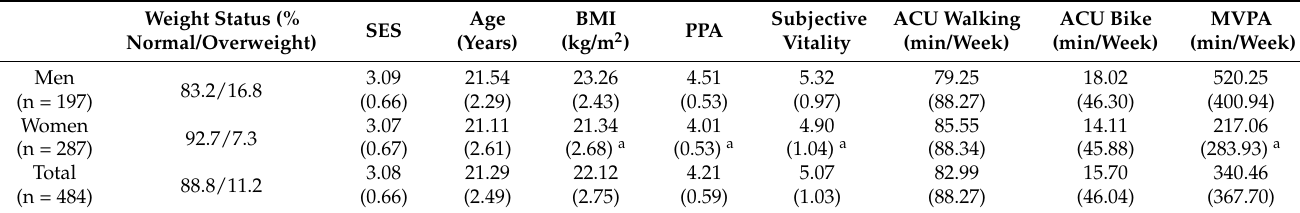
Table 1. Descriptive statistics and pairwise comparisons between